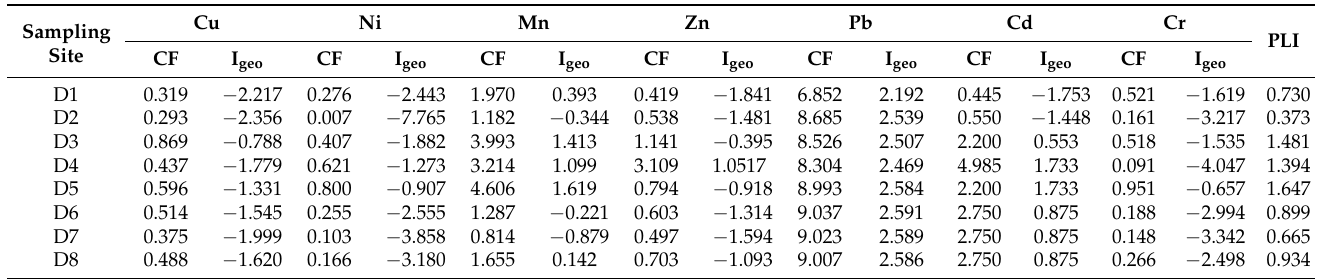
Table 5. Contamination assessment indices for dusts from selected urban roads, highways and pedestrian bridges in Eastern Uganda.